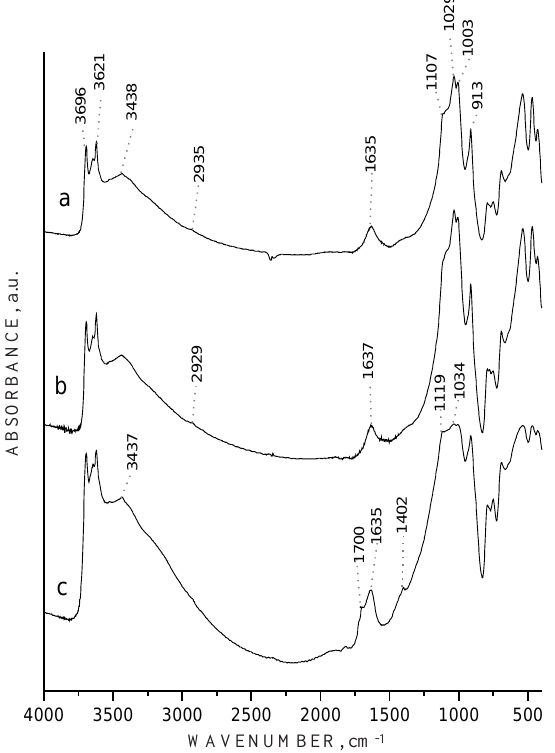
Figure 4. Transmission FTIR spectra of the whole soil (a), of the HS-extracted soil (b) and of the oxidized soil (c) of the